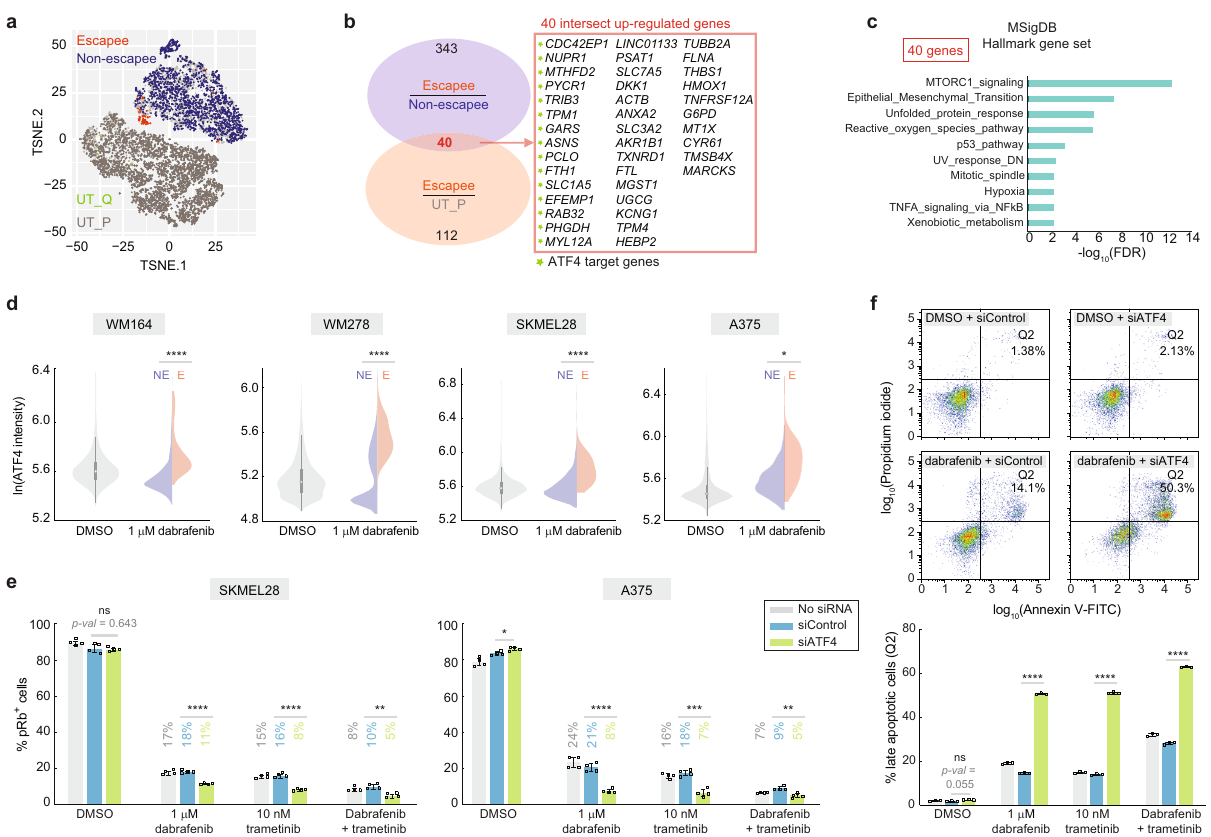
Fig. 4 scRNA-seq reveals upregulation of ATF4 stress signalling in escapees. a Co-visualization of untreated (bottom left) and treated (top right) scRNA-seq datasets on a single t-SNE plot, showing escapees in orange and non-escapees in blue (see Supplementary Fig. 3d for classi fi cation of escapee and non-escapee). Untreated proliferative cells (UT-P) and quiescent cells (UT-Q) were coloured grey and green, respectively. Escapees can be identi fi ed as a small orange peninsula in the treated condition. b Venn diagram of differentially expressed genes as described in the text. Genes labelled with a green star are ATF4 target genes. c MSigDB hallmark gene set enrichment analysis of the 40 genes using the false-discovery rate cutoff of 0.05. d Violin plot showing ATF4 protein levels by immuno fl uorescence in four melanoma cell lines treated with 1- µ M dabrafenib for 72 h. Split violin shows ATF4 levels in non-escapees (NE) and escapees (E) identi fi ed by phospho-Rb (S780) co-staining. Each population value is pooled from three replicate wells. e The percentage of pRb + cells in the indicated conditions. Cells were treated for 72 h. Error bars: mean ± std of four replicate wells, representative of two experimental repeats. f Percentage of late-apoptotic A375 cells with or without ATF4 knockdown, after a 96-h treatment with the indicated drugs. Error bars: mean ± std of three biological replicates, representative of two experimental repeats. Source data are provided as a Source Data fi